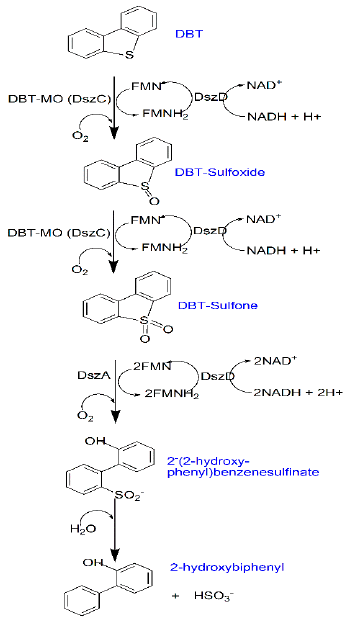
Figure 2. The four-step biodesulfurization (4S) pathway.